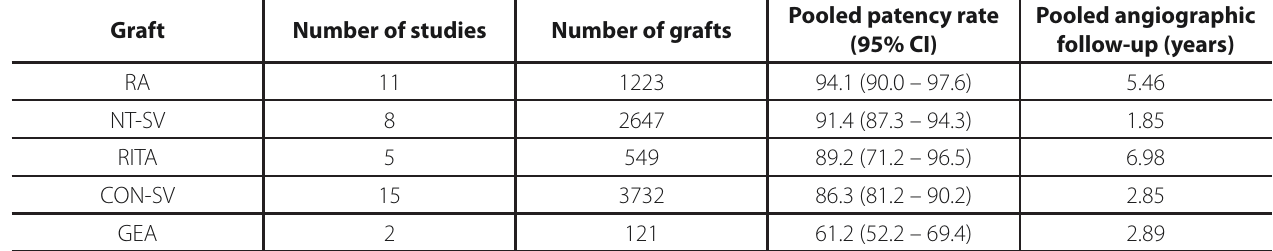
Table 2. Pooled patency of different grafts.